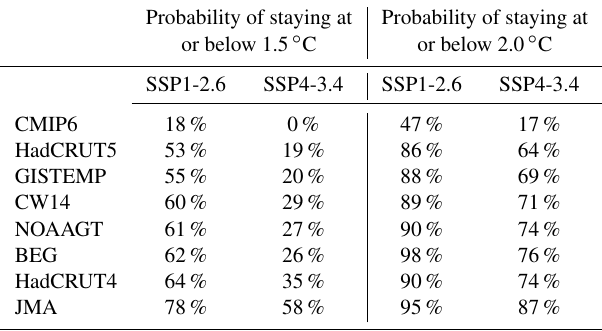
Table 1. Probability of achieving the Paris Agreement target (SSP1- 2.6) or upper limit (SSP4-3.4) for seven GMST records using the EM-GC and the CMIP6 multi-model ensemble. The probabil- ities using the EM-GC are computed using the aerosol weighting method. The probabilities using the CMIP6 models are computed by calculating how many of the models for that scenario are below the temperature limits compared to the total number of models.